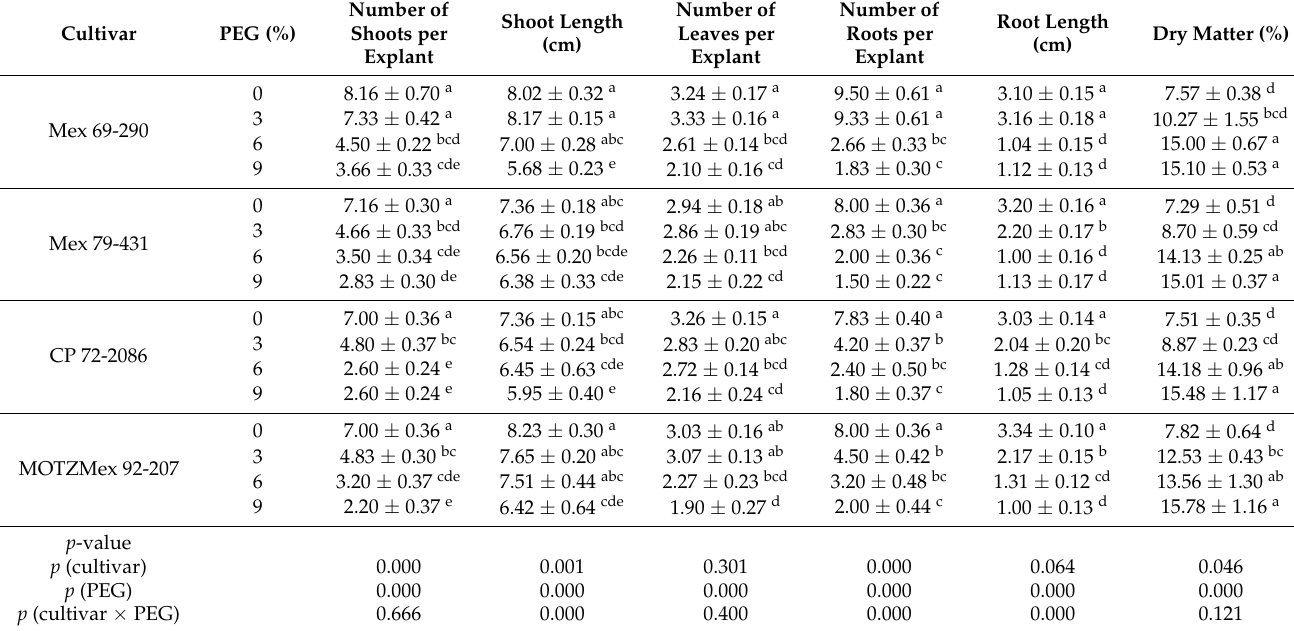
Values represent the mean ± SE. Means with different letters within a column were significantly different (Tukey, p ≤